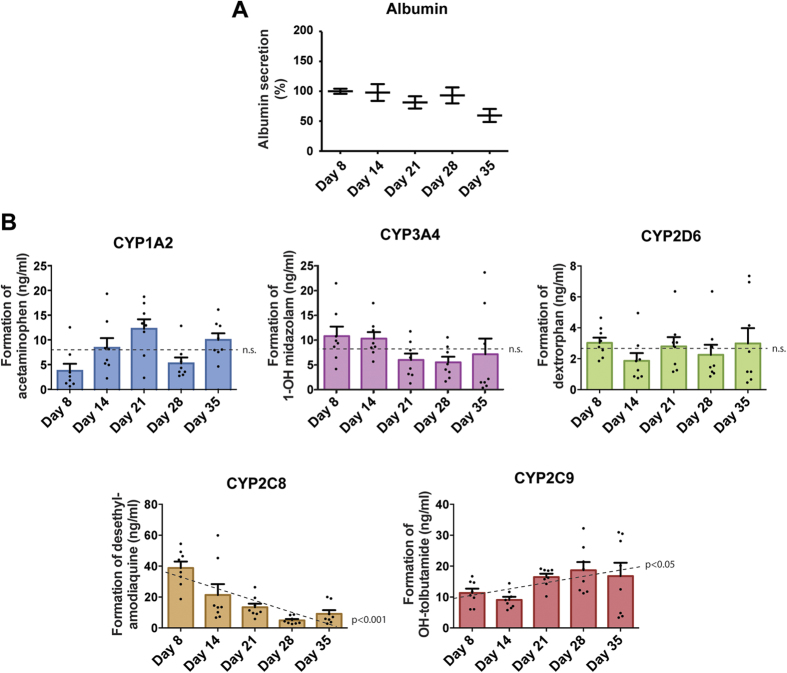
PHH cultured as spheroids remain metabolically active for at least 5 weeks in culture.(A) Albumin secretion normalized to spheroid volumes during long-term spheroid culture (n = 15 spheroids from 3 donors per time point). (B) CYP-dependent metabolic activity of PHH spheroids over 35 days. PHH spheroids were exposed to a cocktail of 5 CYP substrates and the resulting metabolites were analysed via LC-MS/MS (n = 8 spheroids per time point). No changes in rate of drug metabolism were detected for CYP1A2, CYP2D6 and CYP3A4 over the course of 5 weeks (n.s. corresponds to p > 0.05, F-test), whereas CYP2C8 and CYP2C9 activities were found to be significantly decreased (p < 0.001) or increased (p < 0.05) respectively.